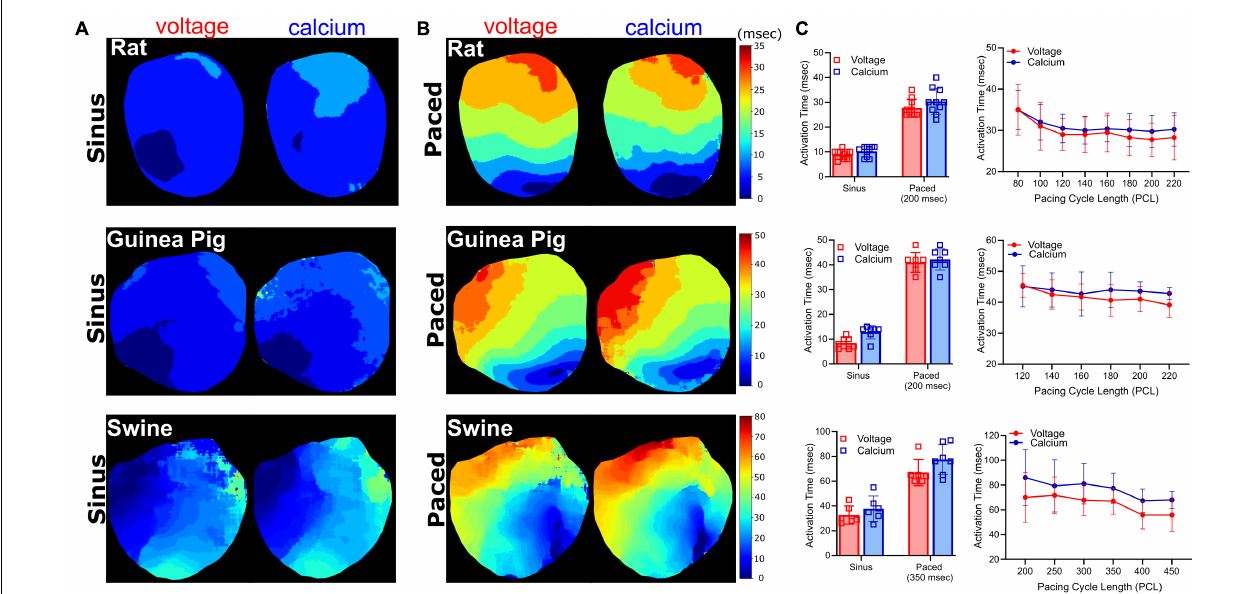
FIGURE 6 | Activation time measurements. Voltage and calcium activation maps generated from excised Langendorff-perfused hearts, during (A) sinus and (B) epicardial dynamic pacing applied to the left ventricle (rat: 200 ms, guinea pig: 200 ms, swine: 350 ms PCL). (C) Left: Average activation time delay during sinus rhythm, compared with dynamic epicardial pacing ( n = 10 rat, n = 7 guinea pig, n = 6–8 swine independent heart preparations). Right: Activation time restitution curves for rat ( n = 4–8), guinea pig ( n = 6–7), and swine ( n = 3–6 independent heart